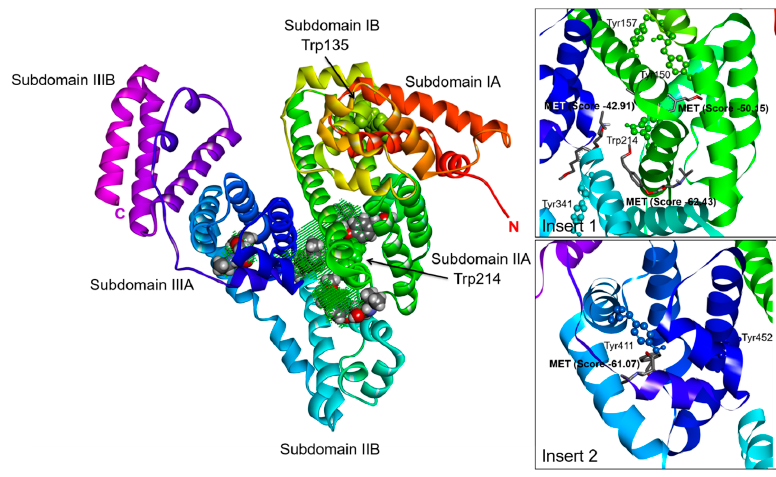
Figure 6. Computational structure of BSA (PDB 4F5S) complexed with METs. In the inserts: molecules of MET in subdomains IIA (insert 1) and IIIA (insert 2).